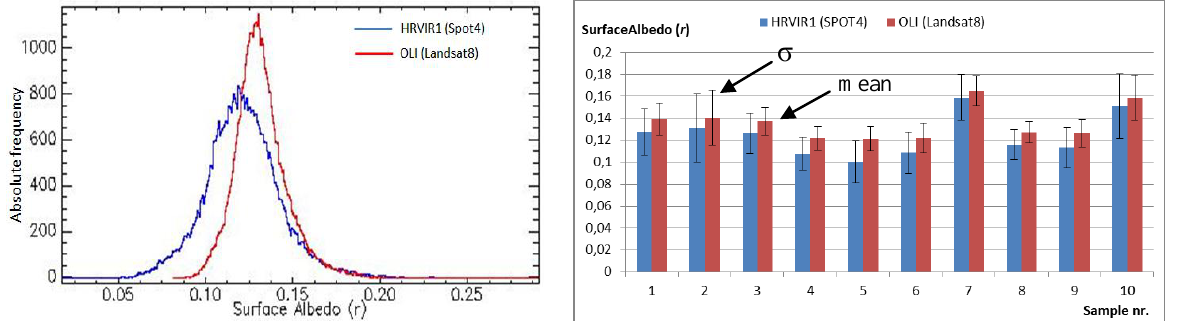
Figure 4. Surface albedo ( r ) estimated with overlapping HRVIR1 (SPOT4) and OLI (Landsat8) data: distribution for the area of overlap ( left ), mean and standard deviation (σ) for 10 samples of 20 pixels × 20 lines ( right ); Faregh district, 26 April